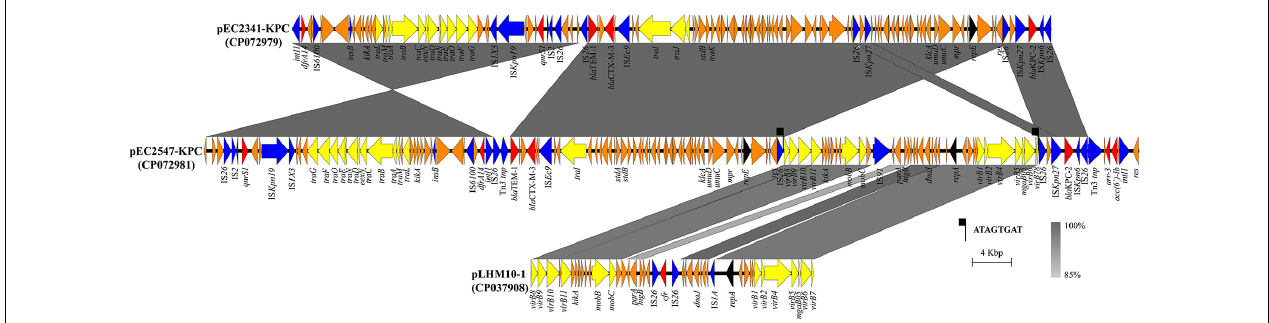
FIGURE 2 | Linear characterization of the plasmids pEC2341-KPC and pEC2547-KPC with closely related plasmid. The gray regions between plasmids indicate nucleotide identity (85–100%) by BLASTn. Arrows indicate predicted ORFs. Primary structural characteristics of plasmids pEC2341-KPC (CP072979), pEC2547-KPC (CP072981), and pLHM10-1 (CP037908). Colored arrows represent open reading frames, with red, yellow, blue, and orange representing antibiotic resistance gene, plasmid transfer related genes, mobile elements and common function genes,